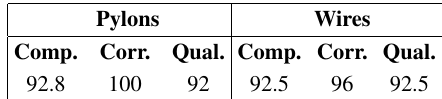
Table 2. Object-based evaluation on the whole